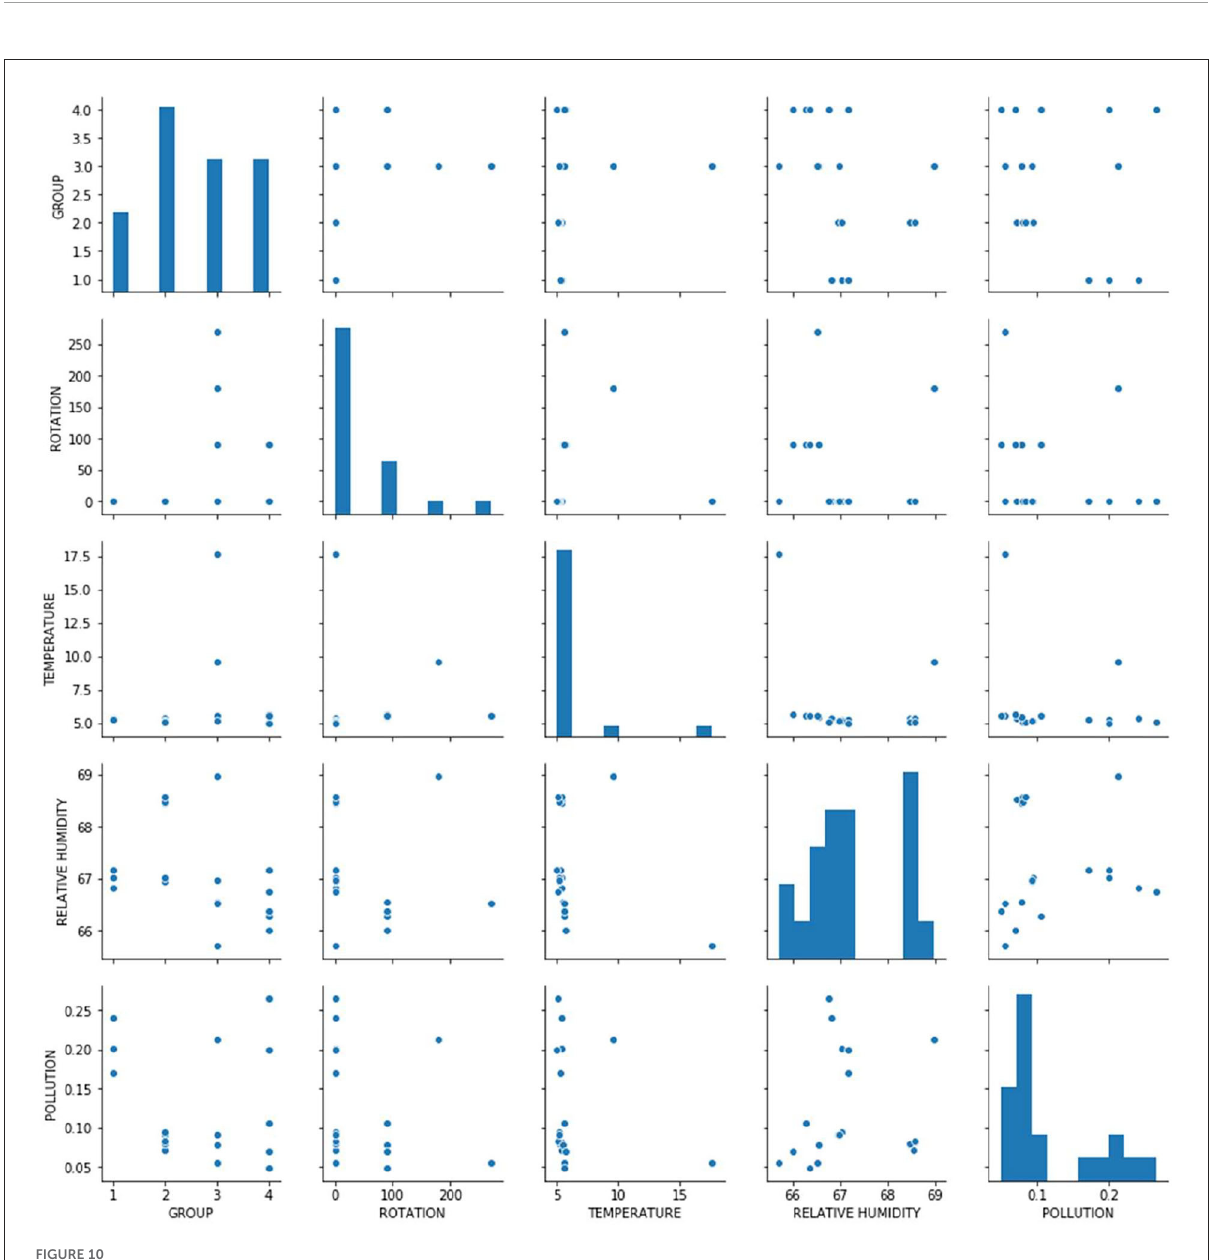
FIGURE10 Pearson’s correlation